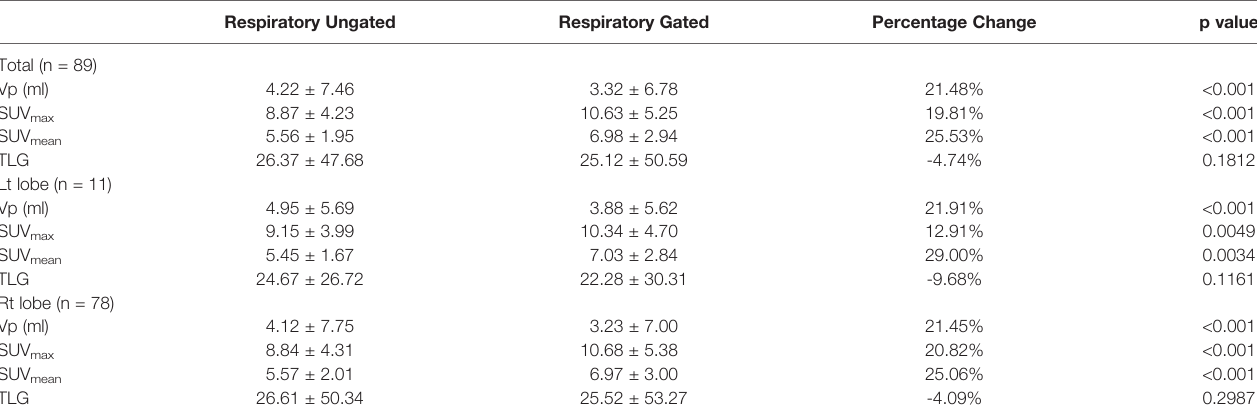
TABLE 2 | PET volume (Vp), and SUV max , SUV mean , and TLG in non-gating and gating PET/CT. Respiratory Ungated Respiratory Gated Percentage Change